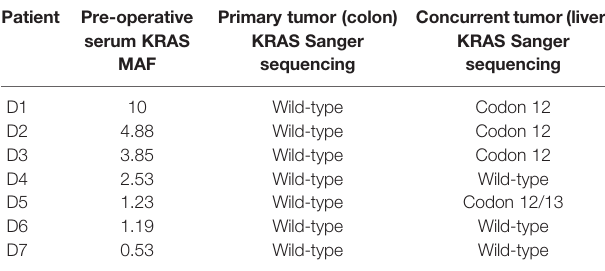
TABLE 3 | Seven discordant KRAS G12/13 (* Table 1 ) cases: pre-operative serum, matched primary and concurrent metastatic tissue. Patient Pre-operative serum KRAS MAF